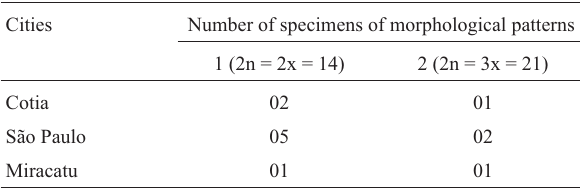
Table 1 - Collection sites of Dolichoplana carvalhoi specimens.